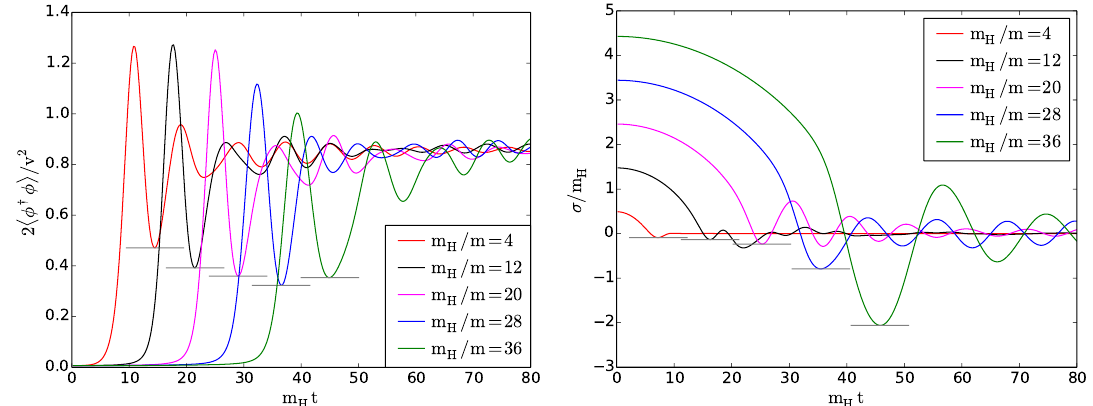
Figure 1 . Left: the average Higgs (cid:12)eld in time, for n = 8 and di(cid:11)erent quench rates m H =m . Black horizontal lines indicate the (cid:12)rst Higgs minimum, used to de(cid:12)ne the quench time T 1 . Right: the (cid:27) (cid:12)eld for the same